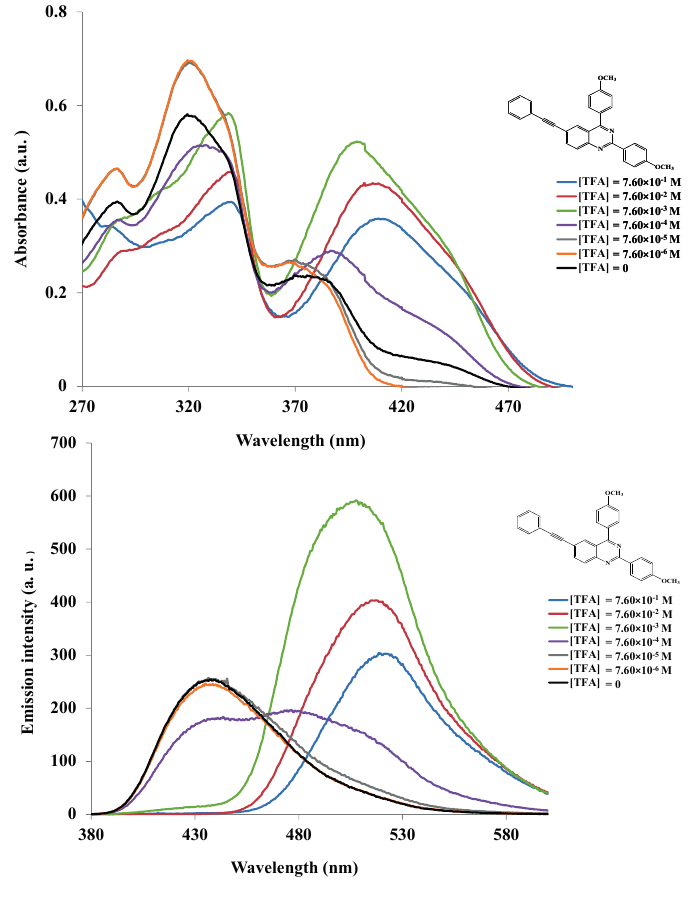
Figure 4. UV-Vis ( upper ) and PL spectra of 5g in CH 2 Cl 2 (conc. = 1.46 × 10 − 5 M) at different concentrations of TFA (10 − 6 to 10 − 1